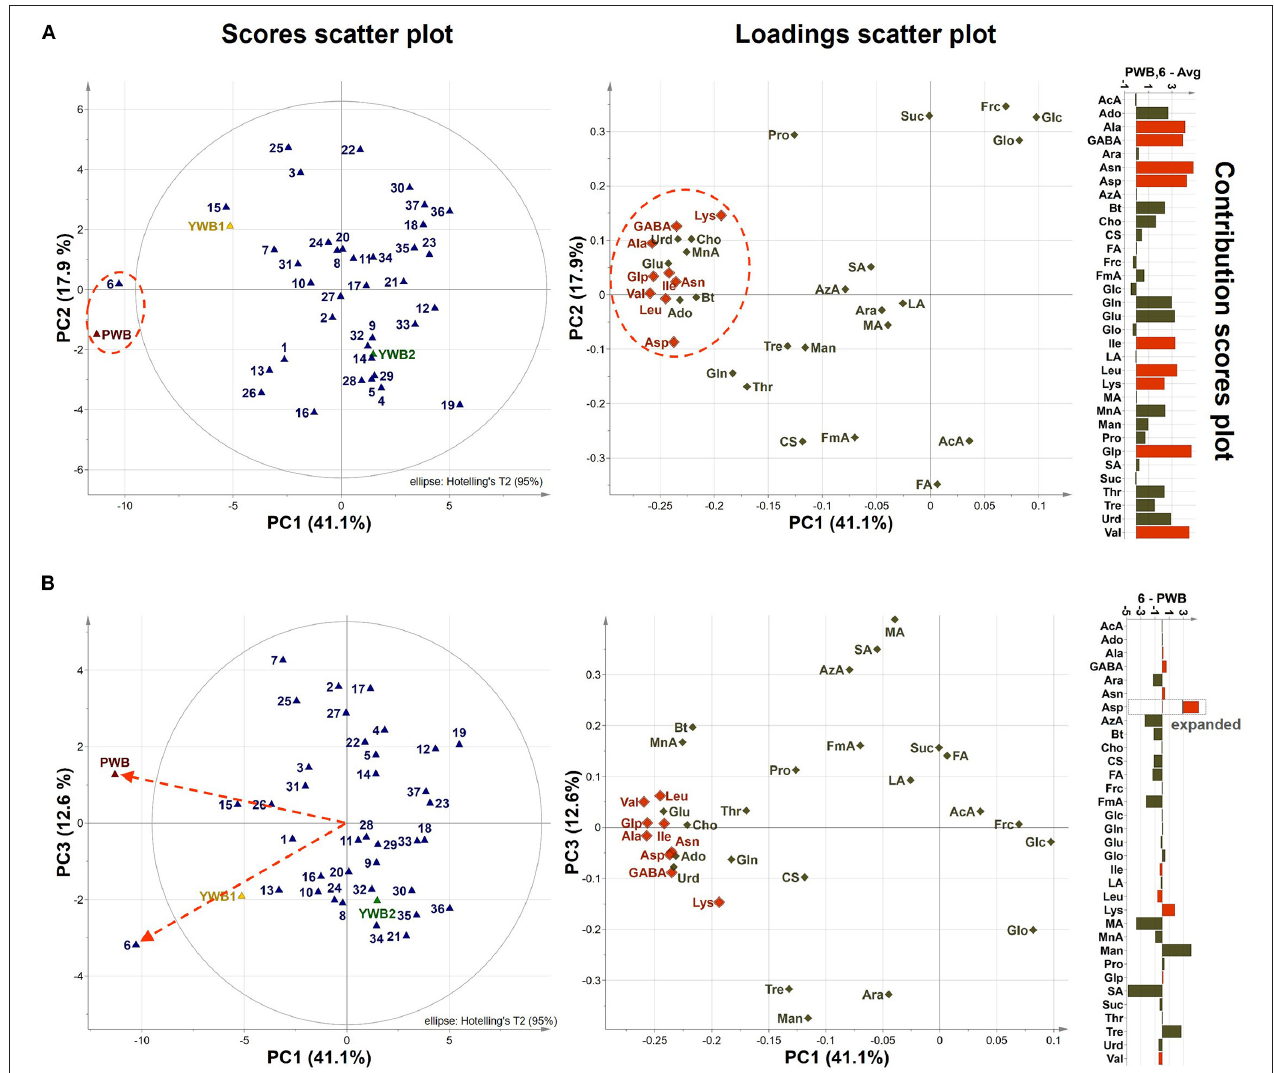
FIGURE 5 | (A) PCA scores and loadings scatter plots of PC1 against PC2 (41.1 and 17.9% variation, respectively), contribution scores plot from average to (PWB, PWBr6) (p1 and p2 loadings were used as weights). (B) PCA scores and loadings scatter plots of PC1 against PC3 (41.1 and 12.6% variation, respectively), and contribution scores plot from PWBr6 to PWB (p1 and p3 loadings were used as weights). Variables outside three-fold standard deviation ranges are highlighted in